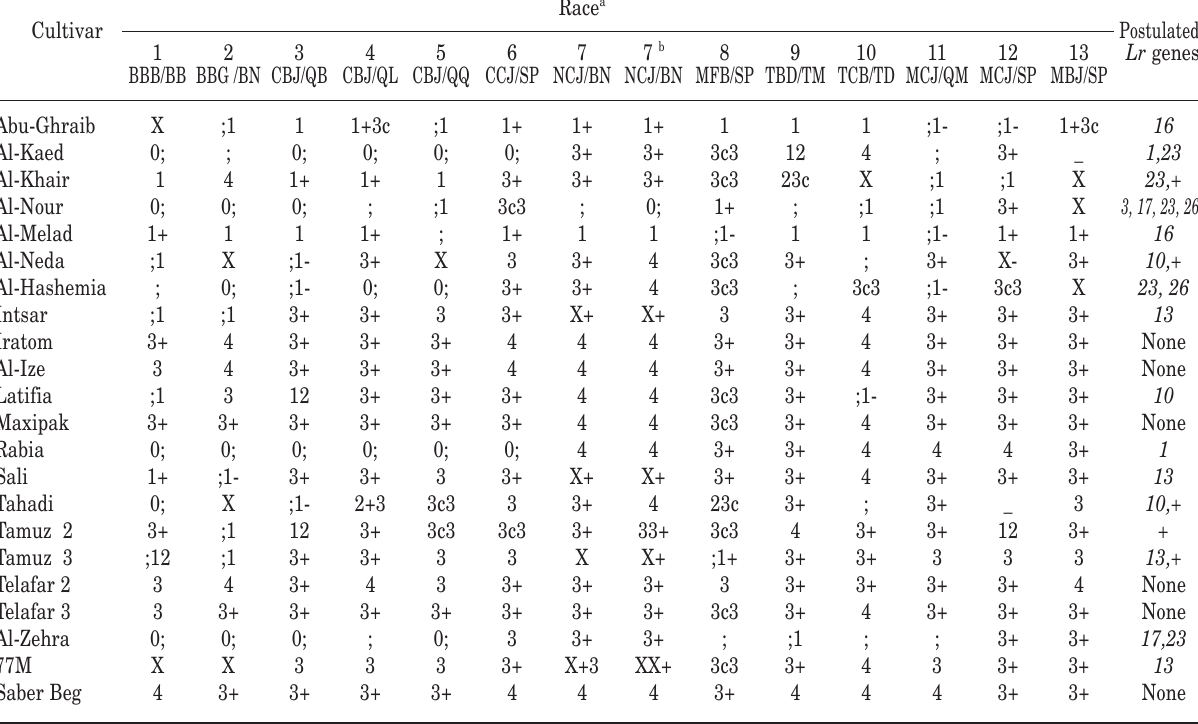
Table 3. Seedling reactions (infection types) displayed by the Iraqi wheat cultivars when inoculated with 13 Pucci- nia triticina races and postulated Lr genes